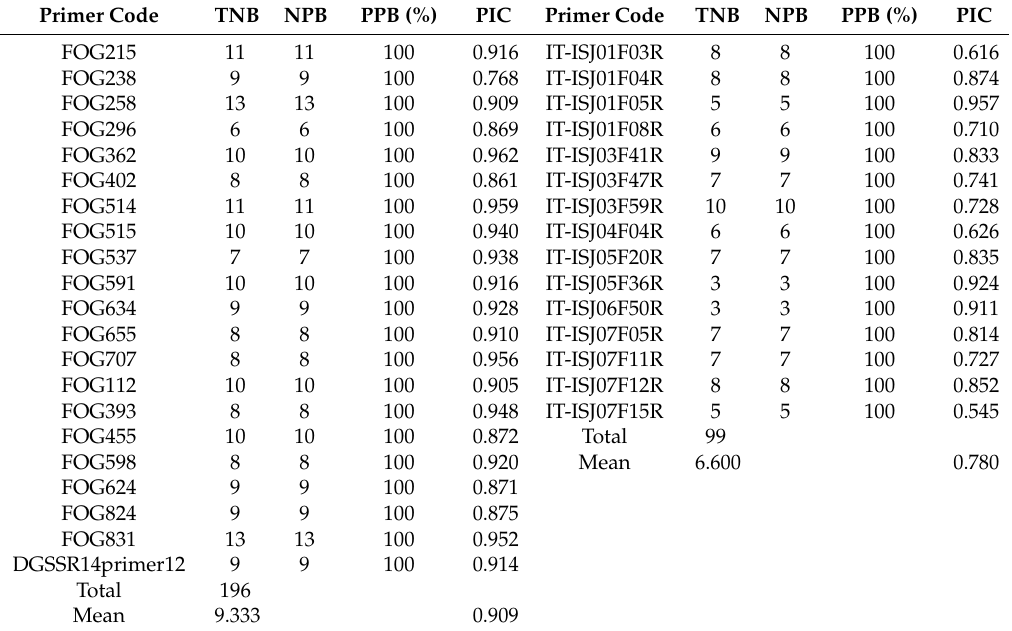
Table 1. Amplification results from SSR and IT-ISJ primer combinations.